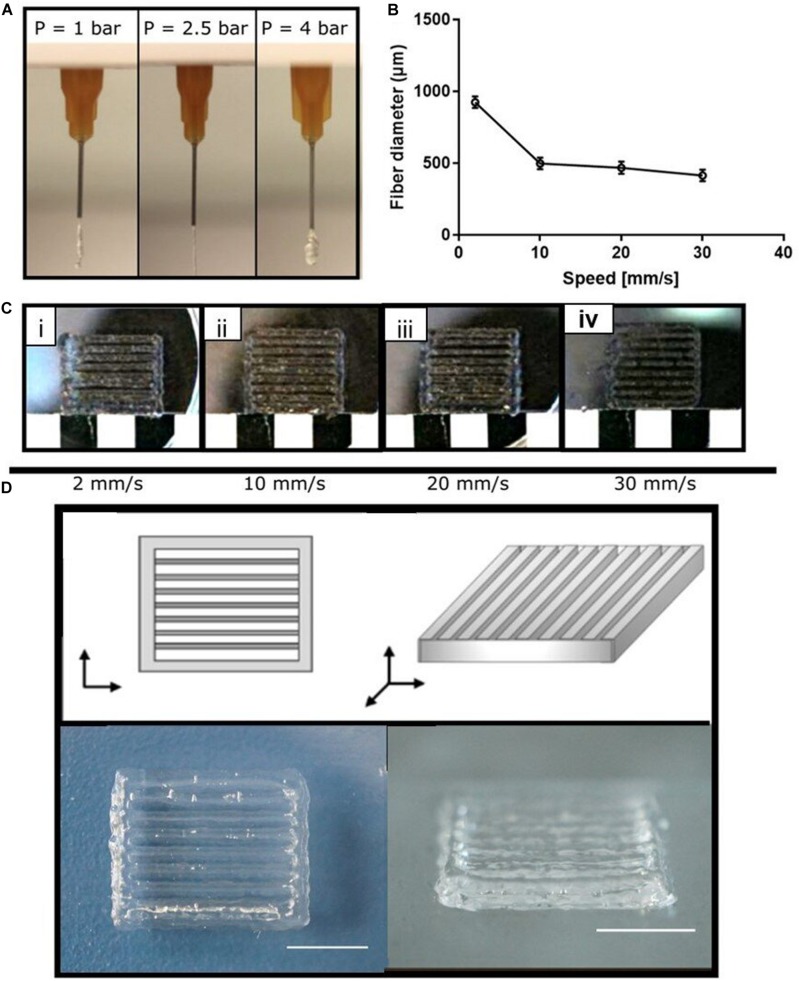
Optimization of the chitosan-gelatin blend printing parameters. (A) Extrusion of the blend at different pressures. (B) Printed fiber diameter at different speed values. (C) Effect of the combination between the selected pressure (P = 2.5 bar) and different speed values; (D) on the top panel schematic representation of the 3D designed scaffold and on the lower panel frontal and lateral view of the obtained 3D printed scaffold (i.e., 1CHI2GEL, 2% w/v chitosan, 4% w/v gelatin).